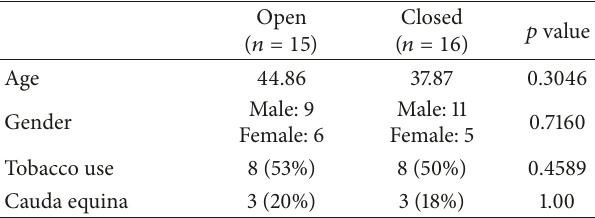
Table 1: Preoperative patient characteristics.